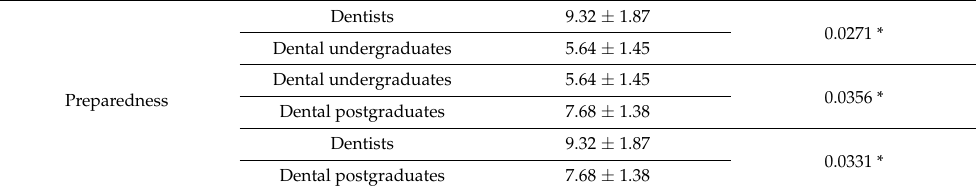
Table 5. Intergroup comparison of preparedness score between dentists, dental undergraduates, and postgraduates.